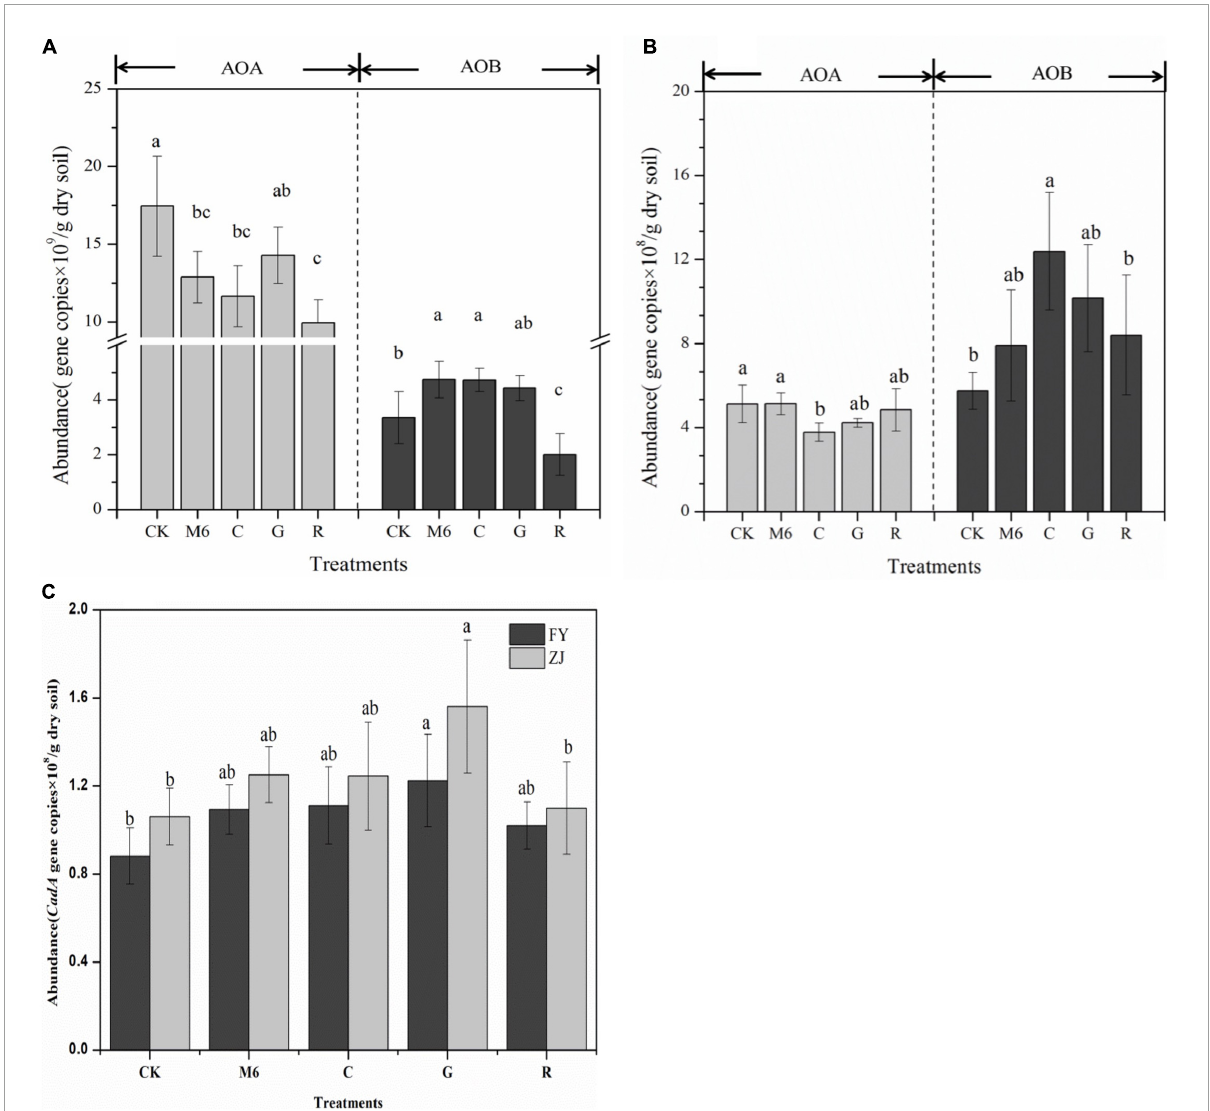
FIGURE3 Abundance of soil functional genes amoA AOA and amoA AOB in (A) HC (B) LC soils collected from two different soils. (C) The abundance of cadA genes in two soils. Data points represent means the standard deviations ( n = 3). The various lowercase letters indicate significant differences among all treatments at p < 0.05. CK, control; M6, M6 strain; C, M6 + Biochar; G, M6 + Glutamic acid; R, M6 + rhamnolipid; FY, Fuyang County; ZJ, Zhuji County; LC, low cadmium; HC, high